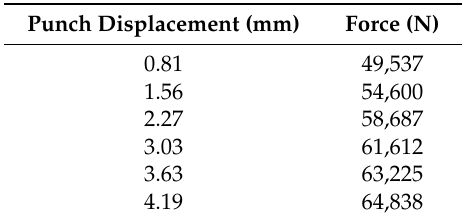
Table 6. Experimentally obtained values of F 1 to F 6 .